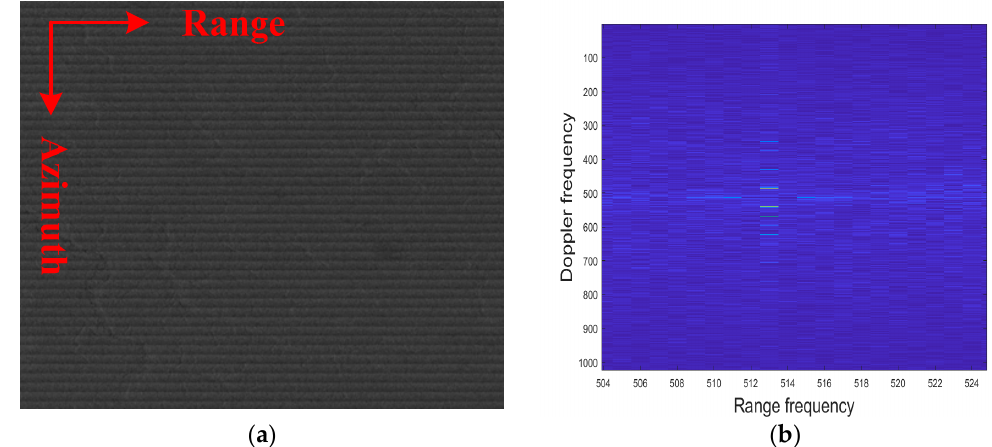
Figure 6. Amazon rainforest image of GF-3: ( a ) part of the Amazon rainforest image of GF-3 NSC mode; ( b ) power spectrum of ( a ).